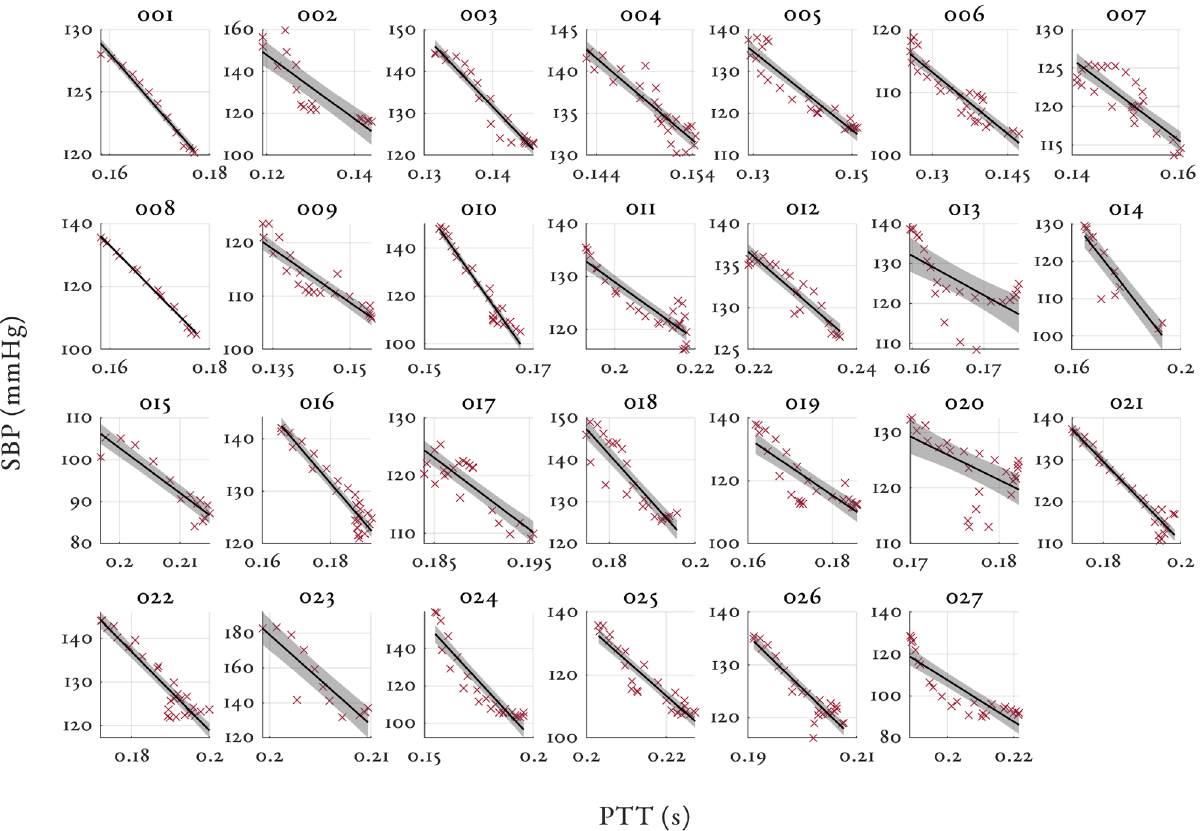
Figure 5. Individual relationships between SBP (mmHg) and PTT (s) for all volunteers in the study. The 95% confidence intervals are shown by the shaded region for each volunteer. Please note again the wide variation in y-axis scaling. PAT PTT